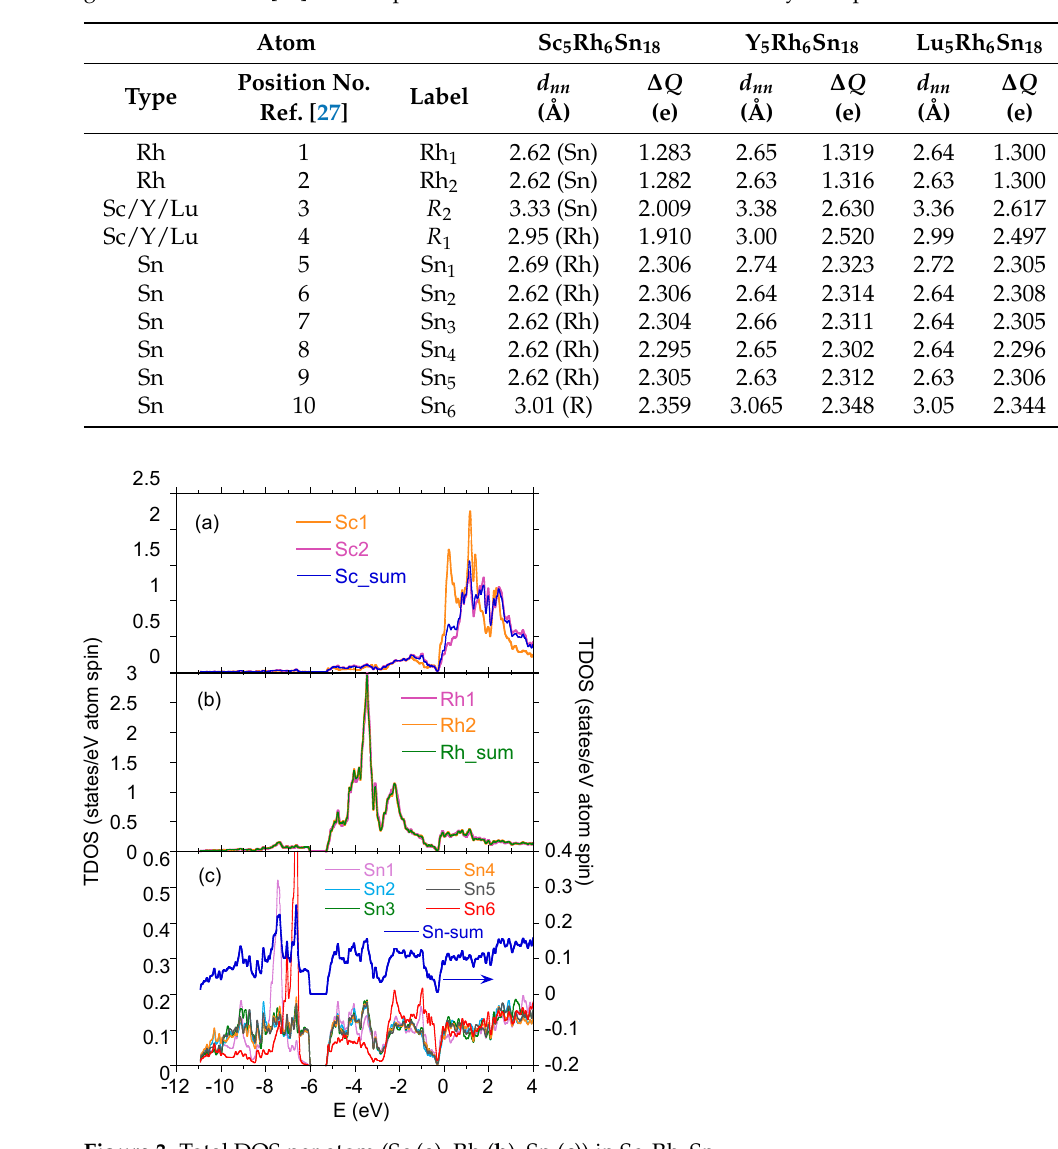
Figure 3. Total DOS per atom (Sc ( a ), Rh ( b ), Sn ( c )) in Sc 5 Rh 6 Sn 18